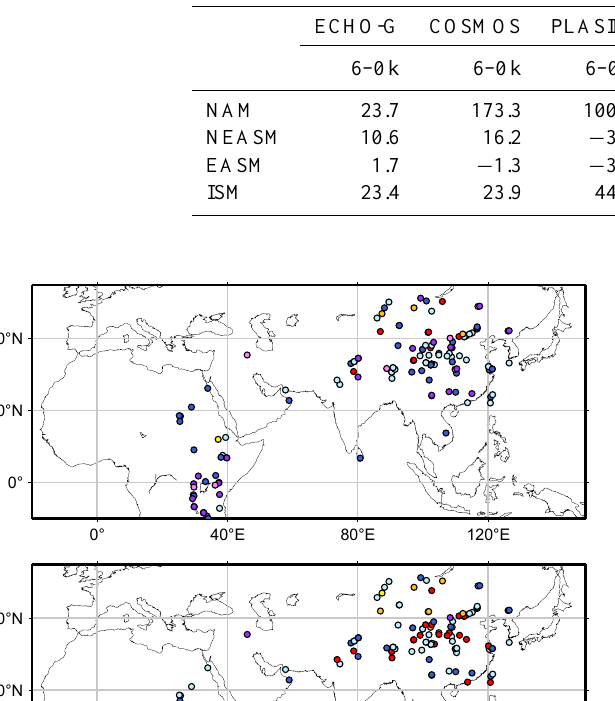
Table 6. Annual mean relative precipitation difference (%) between 6 and 0k for each simulation, averaged over the different monsoon sub-regions. For KCM, the precipitation differences between 9 and 6k and 9 and 0k are also shown.